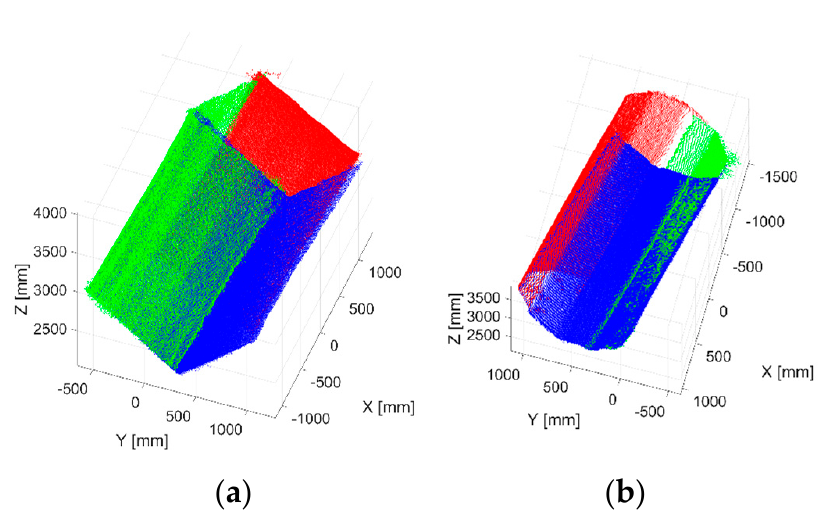
Figure 5. Three-dimensional reconstruction of the rectangular ( a ) and decagonal ( b ) tensile structures example (different colors refer to point clouds acquired from the three sensors).